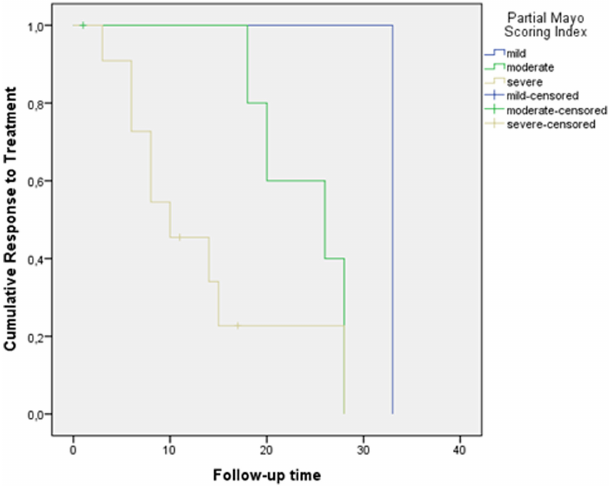
Figure 2. Treatment response according to Partial Mayo Scoring Index in patients with ulcerative